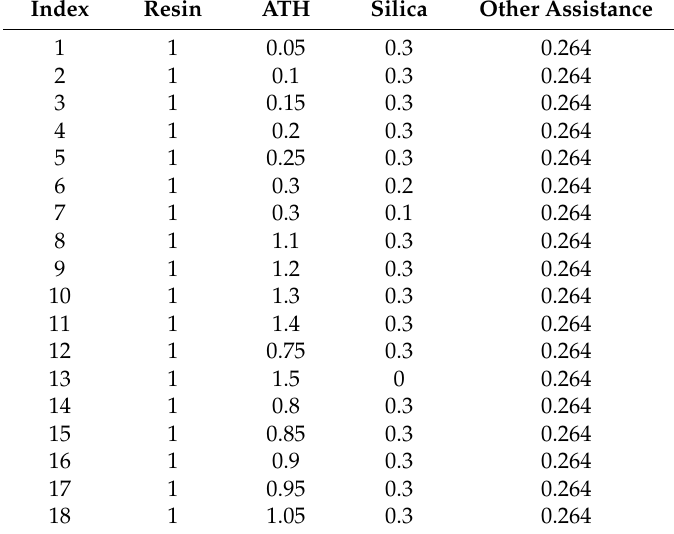
Table 1. Concentrations of 27 samples. The numerical value represents mass fraction taking resin content as a